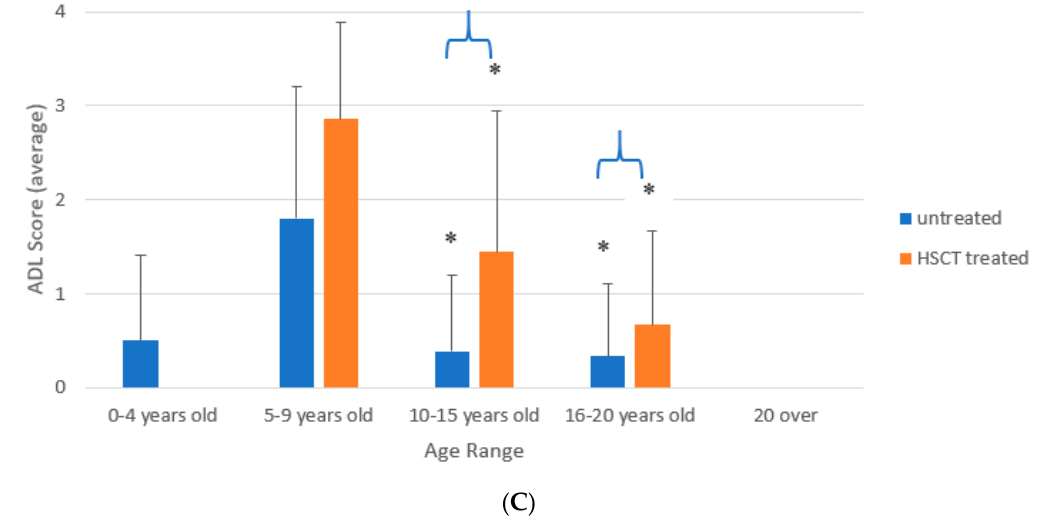
Figure 2. ( A ) Verbal function ADL scores of severe phenotype HSCT-treated and untreated groups. * = p < 0.05. ( B ) Gross motor function ADL scores of severe phenotype HSCT-treated and untreated groups. * = p < 0.05. ( C ) Level of Care ADL scores of severe phenotype HSCT-treated and untreated groups. * = p < 0.05.